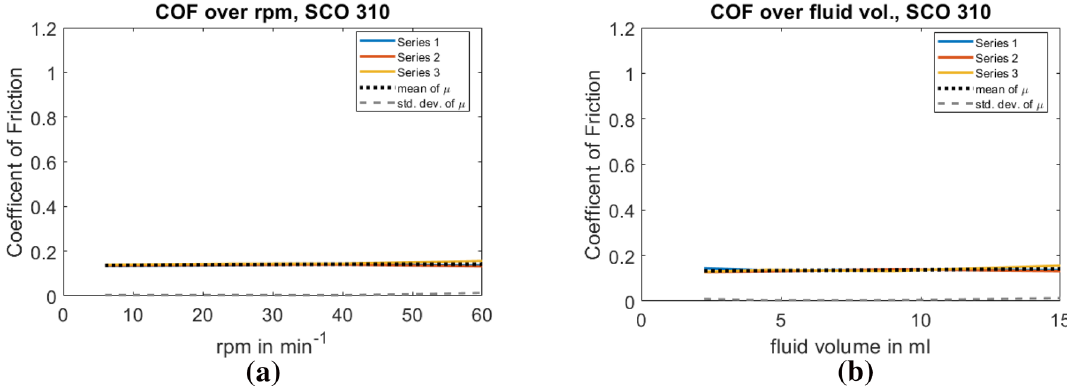
Fig. 5 Measured coefficient of friction for grinding oil: a over rotational speed when fully filled, b over the fluid quantity at 40